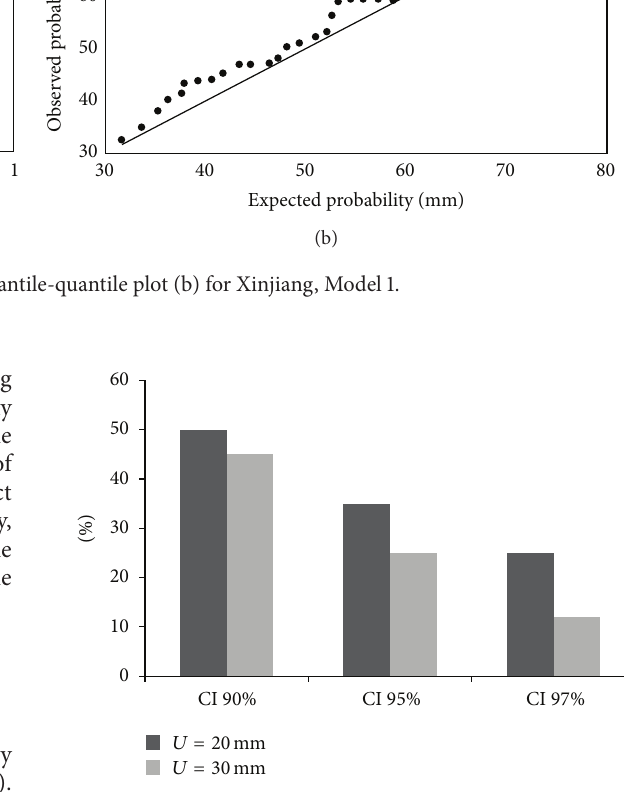
Figure 6: Percentage of stations with significant positive trends in frequency exceeding indicated